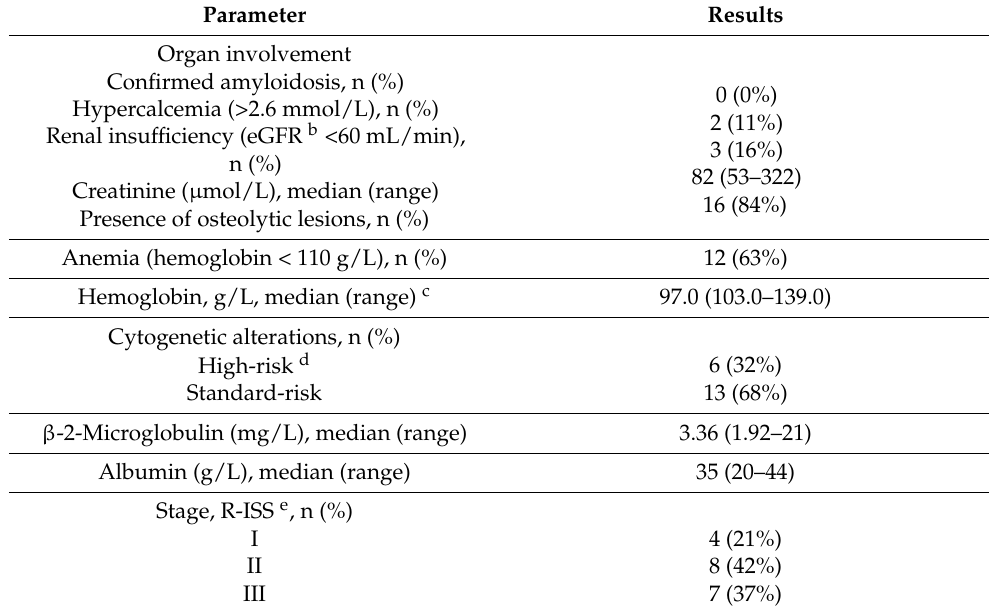
Table 1. Cont. Parameter